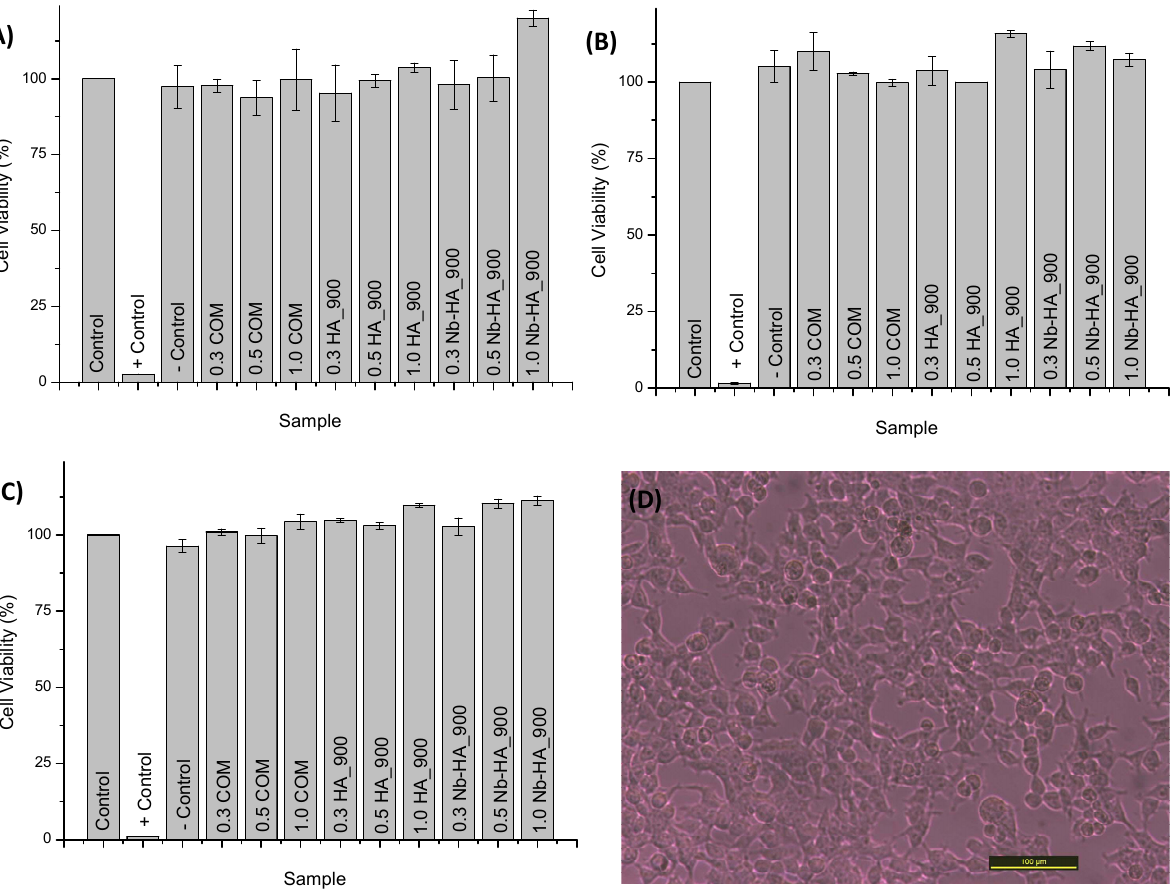
Figure 12. Results of cell viability assay by Resazurin after 24 h ( A ); 48 h ( B ); and 72 h ( C ); SAOS cell viability results after exposure to Nb-HA_900 ( D